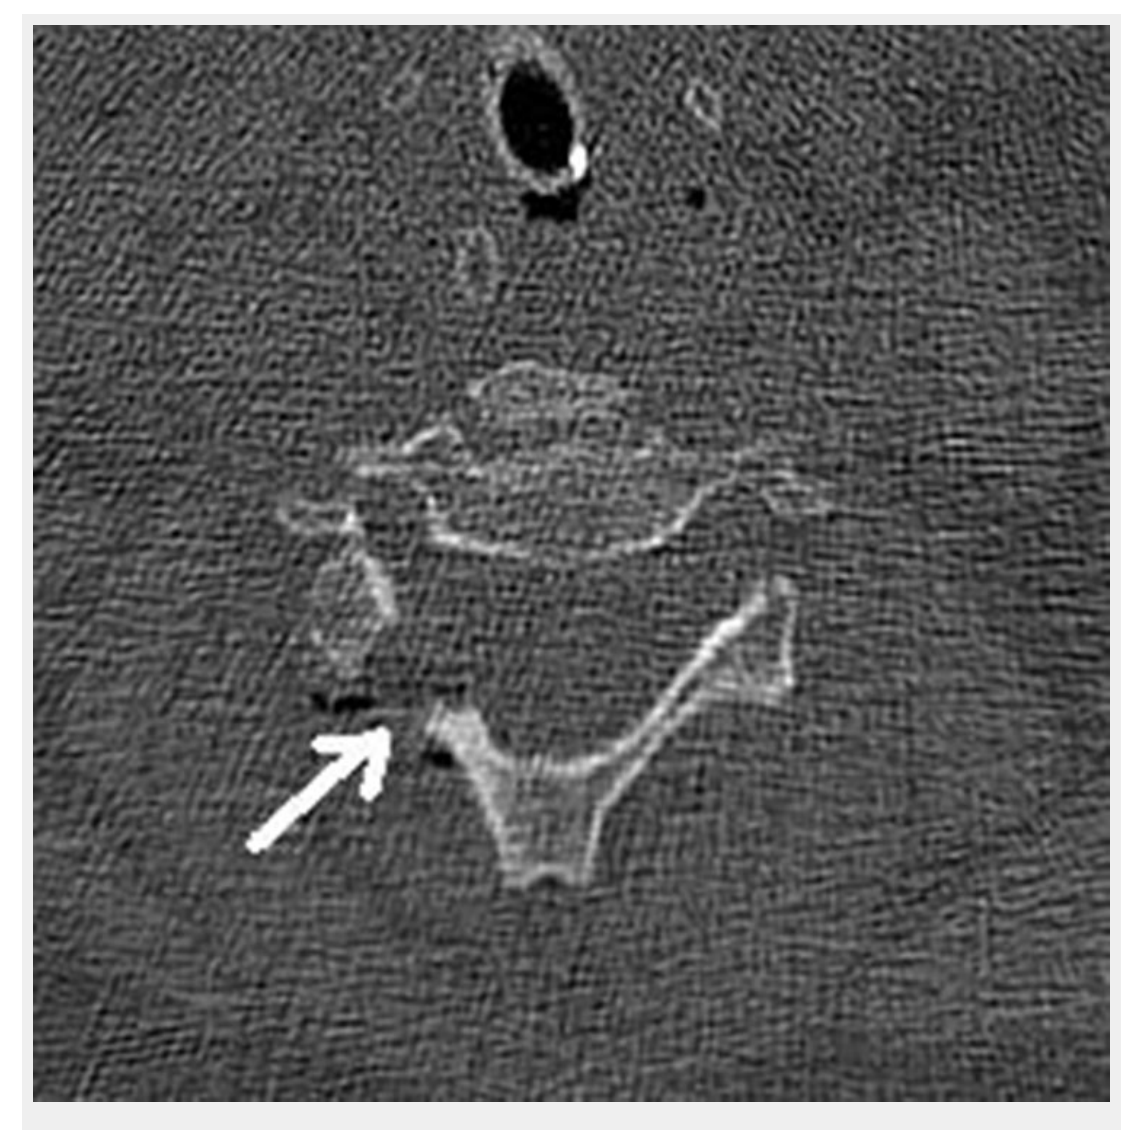
Figure 5 Partial laminectomy led to immediate pain relief ( C